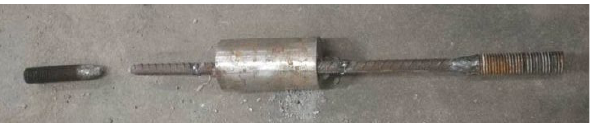
Figure 11. Steel bar tensile failure.